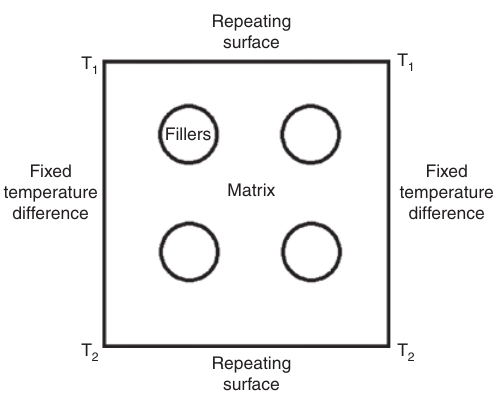
Figure 2: Boundary conditions for finite element models.